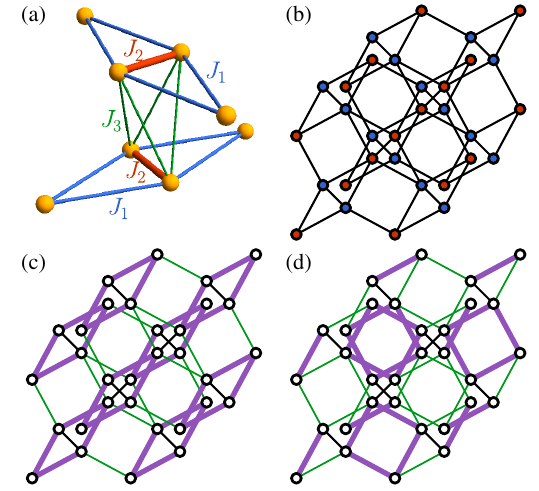
FIG. 12. (a) Three-dimensional interlayer AFM coupling J 3 among spins located at the cross between upper and lower diagonal bonds, mediated by the interpenetrating oxygen atom. The other interlayer couplings are negligible. Preferred stacking of (b) the N´eel ordered phase with n ð l Þ ¼ n ð l þ 1 Þ (red and blue dots for opposite spins), and (c) the diamond PVBS phase with Re M ð l Þ ¼ Re M ð l þ 1 Þ and (d) square PVBS phase with Im M ð l Þ ¼ − Im M ð l þ 1 Þ (thick purple bonds mark singlet plaquettes). For the (c) and (d) cases, energetically favorable stacking can be deduced by the interlayer dimer